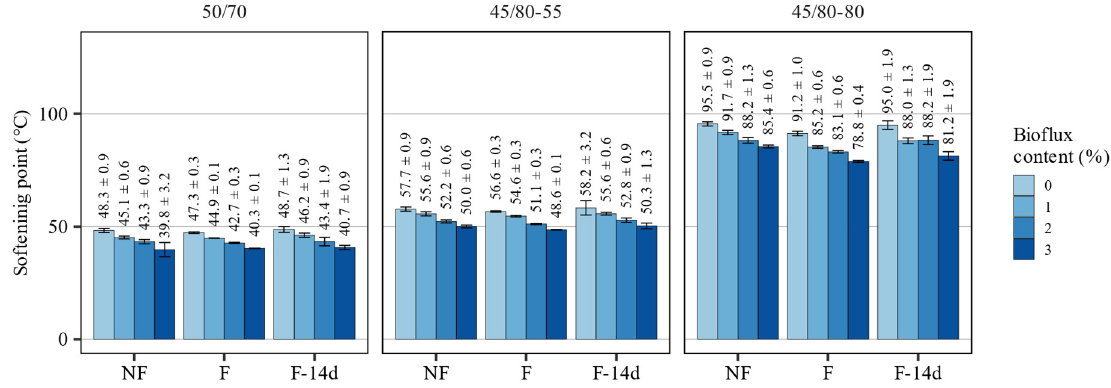
Figure 2. Results of softening point measurements of the investigated asphalt binders.